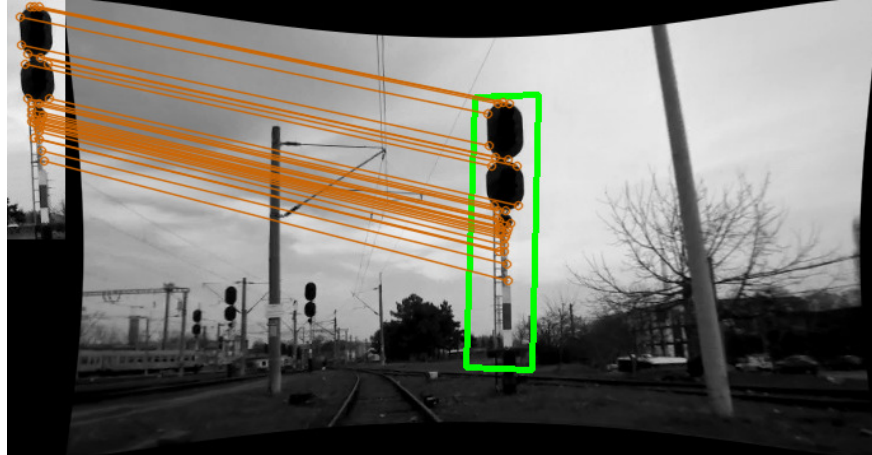
Figure 3. Target detection. Matching result with the reference and scene image.